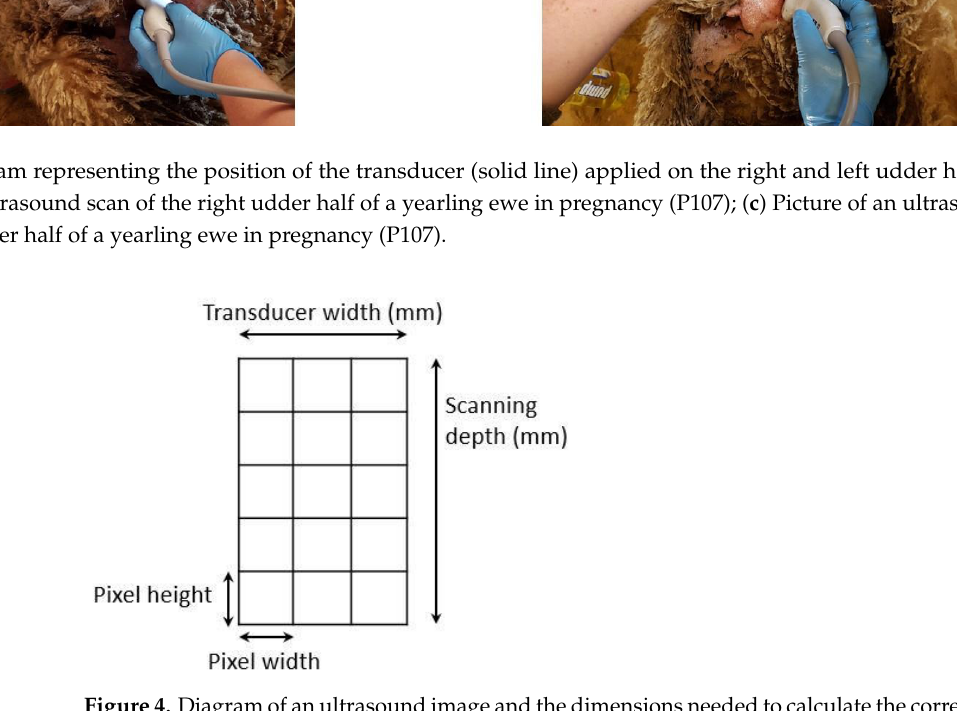
Figure 3. ( a ) Diagram representing the position of the transducer (solid line) applied on the right and left udder halves; ( b ) Picture of an ultrasound scan of the right udder half of a yearling ewe in pregnancy (P107); ( c ) Picture of an ultrasound scan of the left udder half of a yearling ewe in pregnancy (P107).